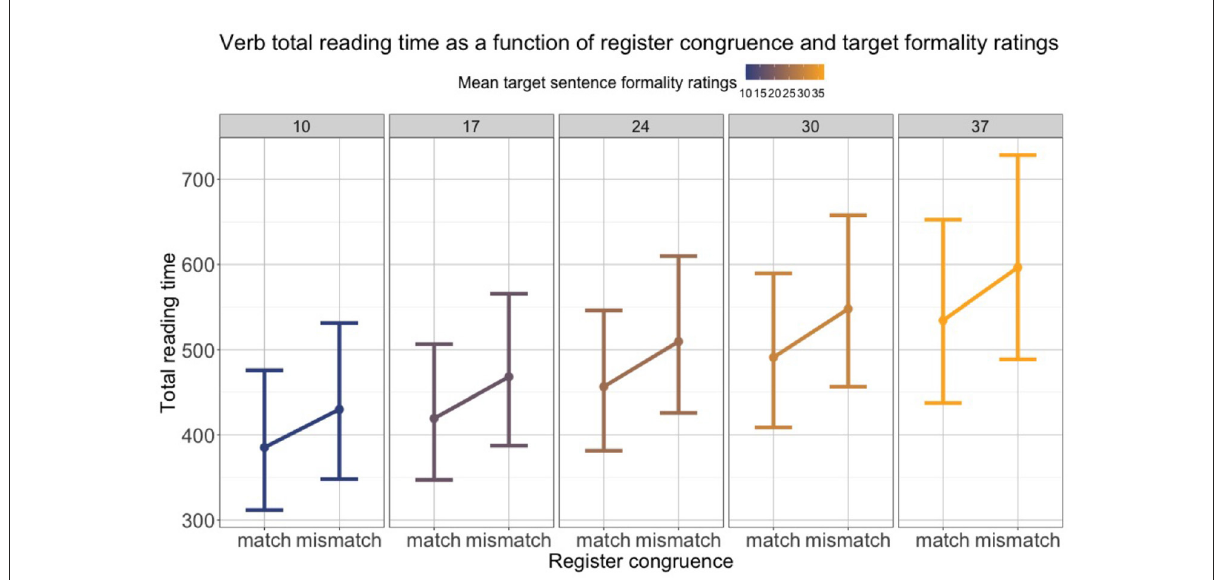
FIGURE10 Project C03: Effects of register congruence and average target sentence formality ratings (obtained through an independent Web-based rating task, on a scale from 0 = very informal, to 50 = very formal) on target verb total reading time, in an eye-tracking pilot study ( N = 8).